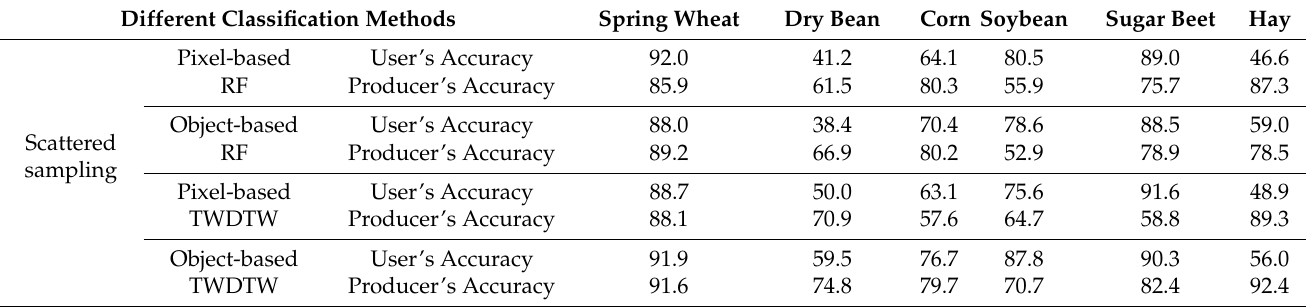
Table 2. Producer’s and User’s accuracies (unit: %) under different sampling strategies, perspectives, and